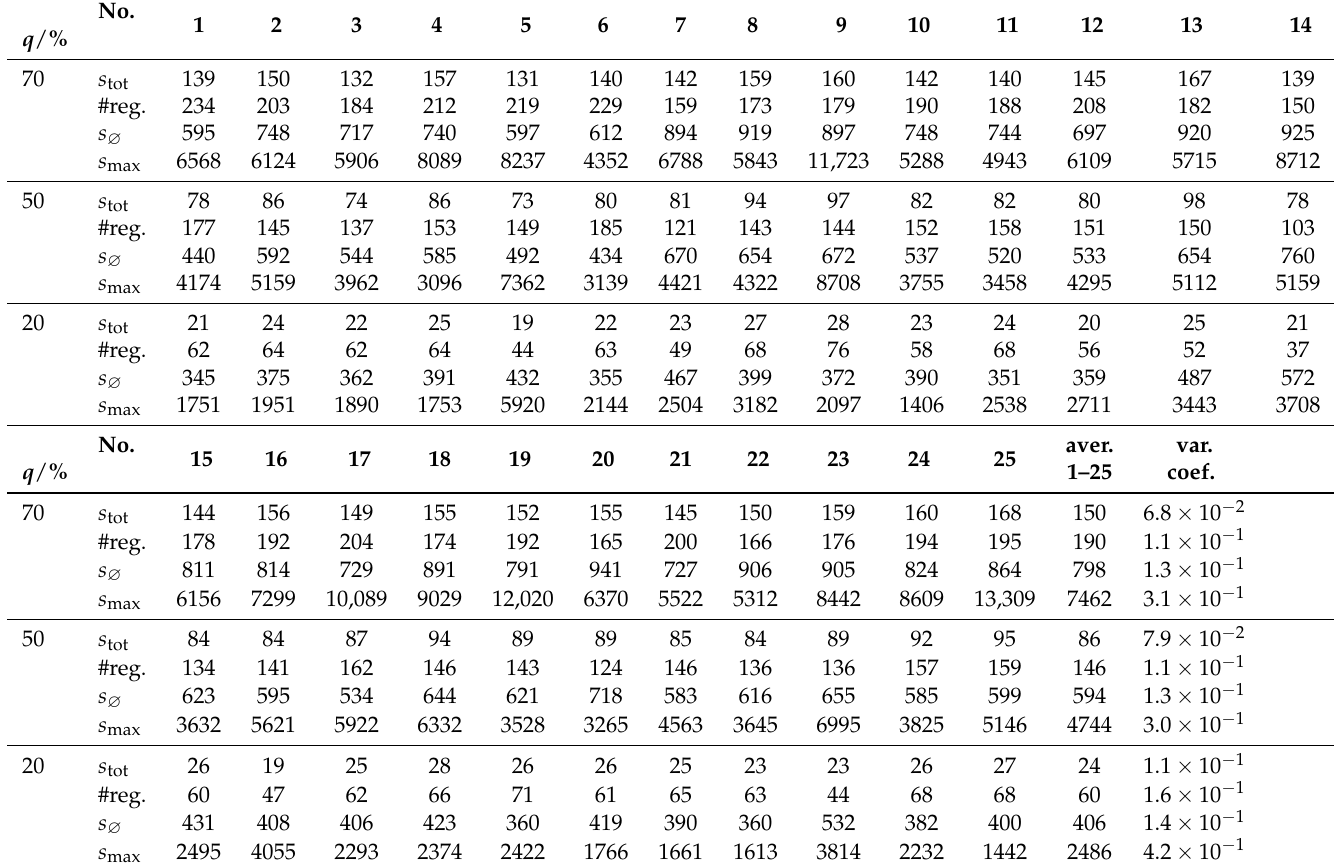
Table 4. Analysis of the GDL/channel interface, 30% compression. s tot in 1000 µm 2 . s ∅ , s max in µm 2 . Total surface: 590,000 µm 2